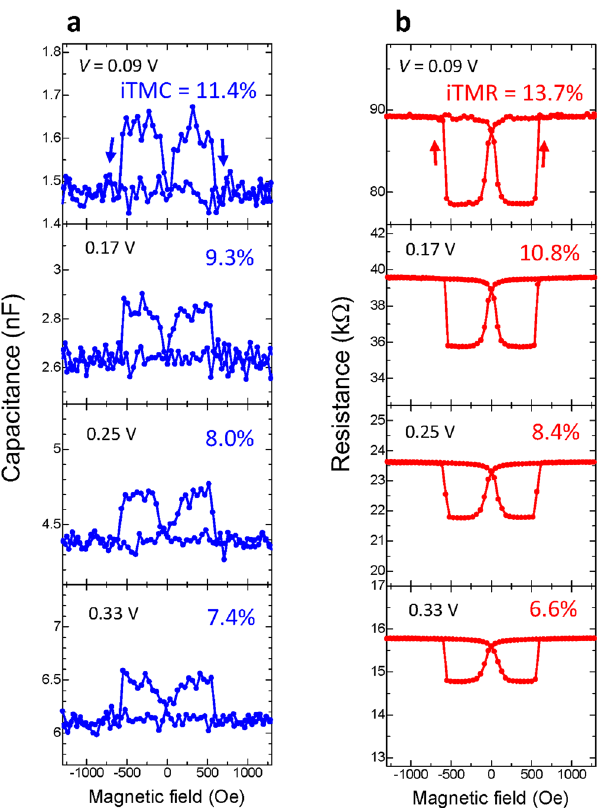
Figure 7. Inverse TMC and TMR. ( a ) Inverse TMC and ( b ) inverse TMR at 20 Hz in the sample C for positive bias voltages of 0.09, 0.17, 0.25 and 0.33